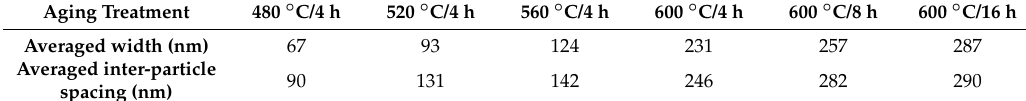
Table 1. Averaged width and inter-particle spacing of intragranular α after aging treatments.